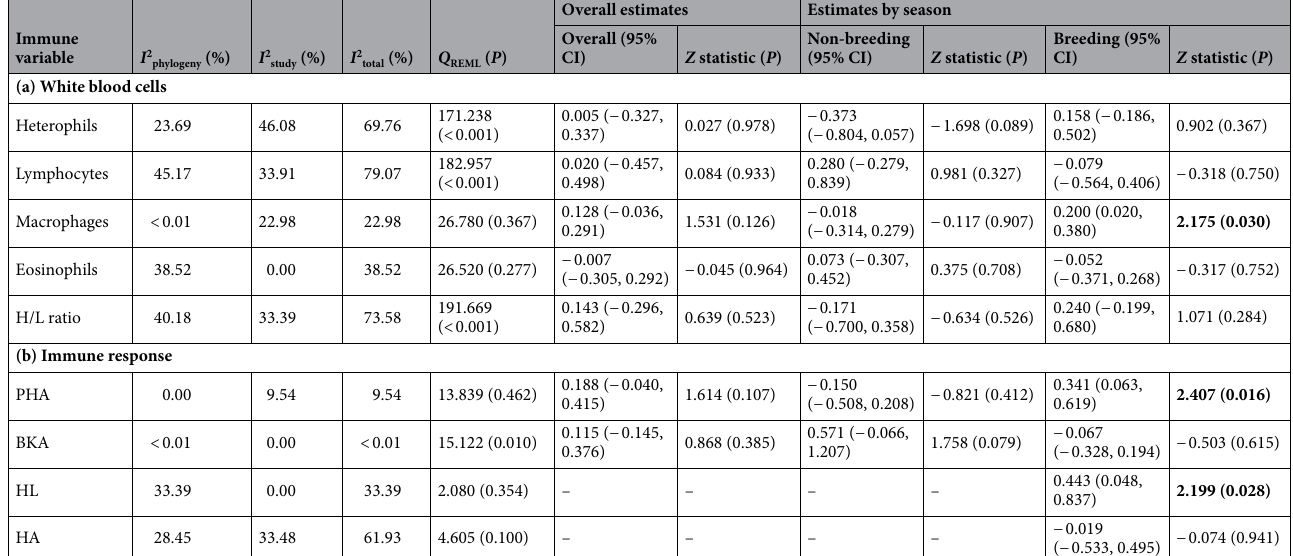
Table 1. Sex bias in (a) white blood cell types and the H/L ratio, and (b) immune response assays in adult wild birds. p values < 0.05 in bold. H/L ratio, heterophils/lymphocytes ratio; PHA, phytohaemagglutinin test; BKA, bacteria-killing ability assay; HL, haemolysis assay; HA, haemagglutination assay; I 2 phylogeny , variance due to phylogenetic relatedness; I 2 study , variance due to differences among studies; I 2 total , total variance attributed to the random effect; Q REML , Cochran’s Q test for (residual) heterogeneity. Z statistic tests if immune parameter estimate differ from zero (no sex difference).